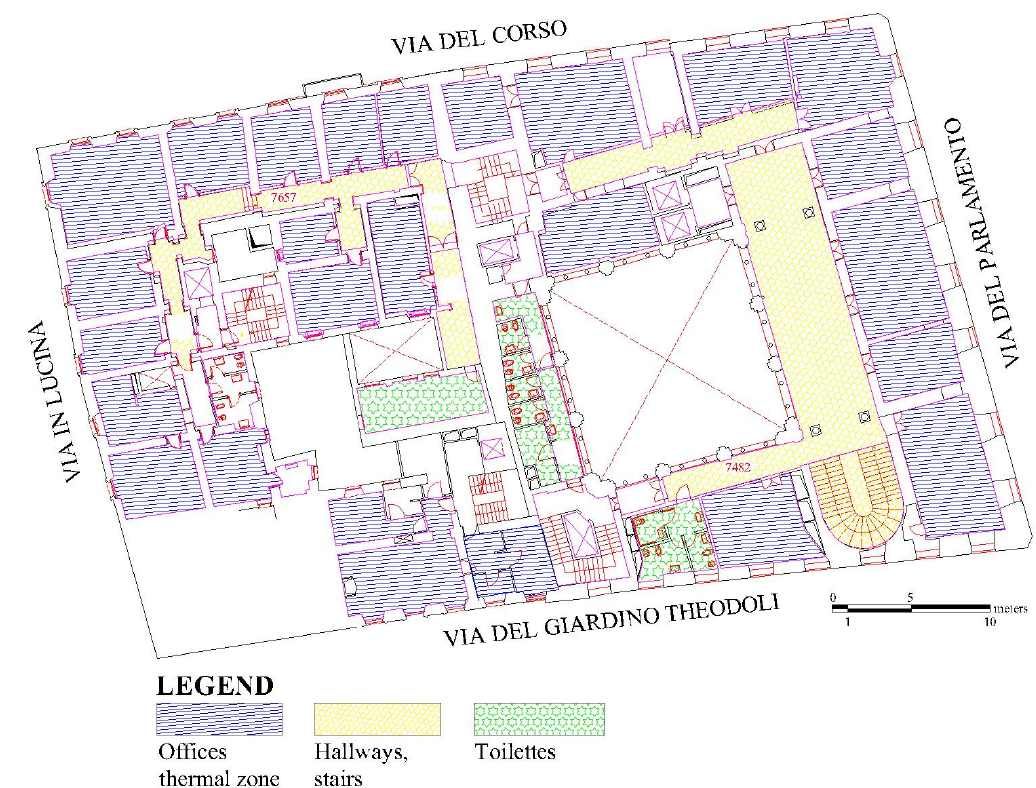
Figure 4. Designated uses on the ground floor.